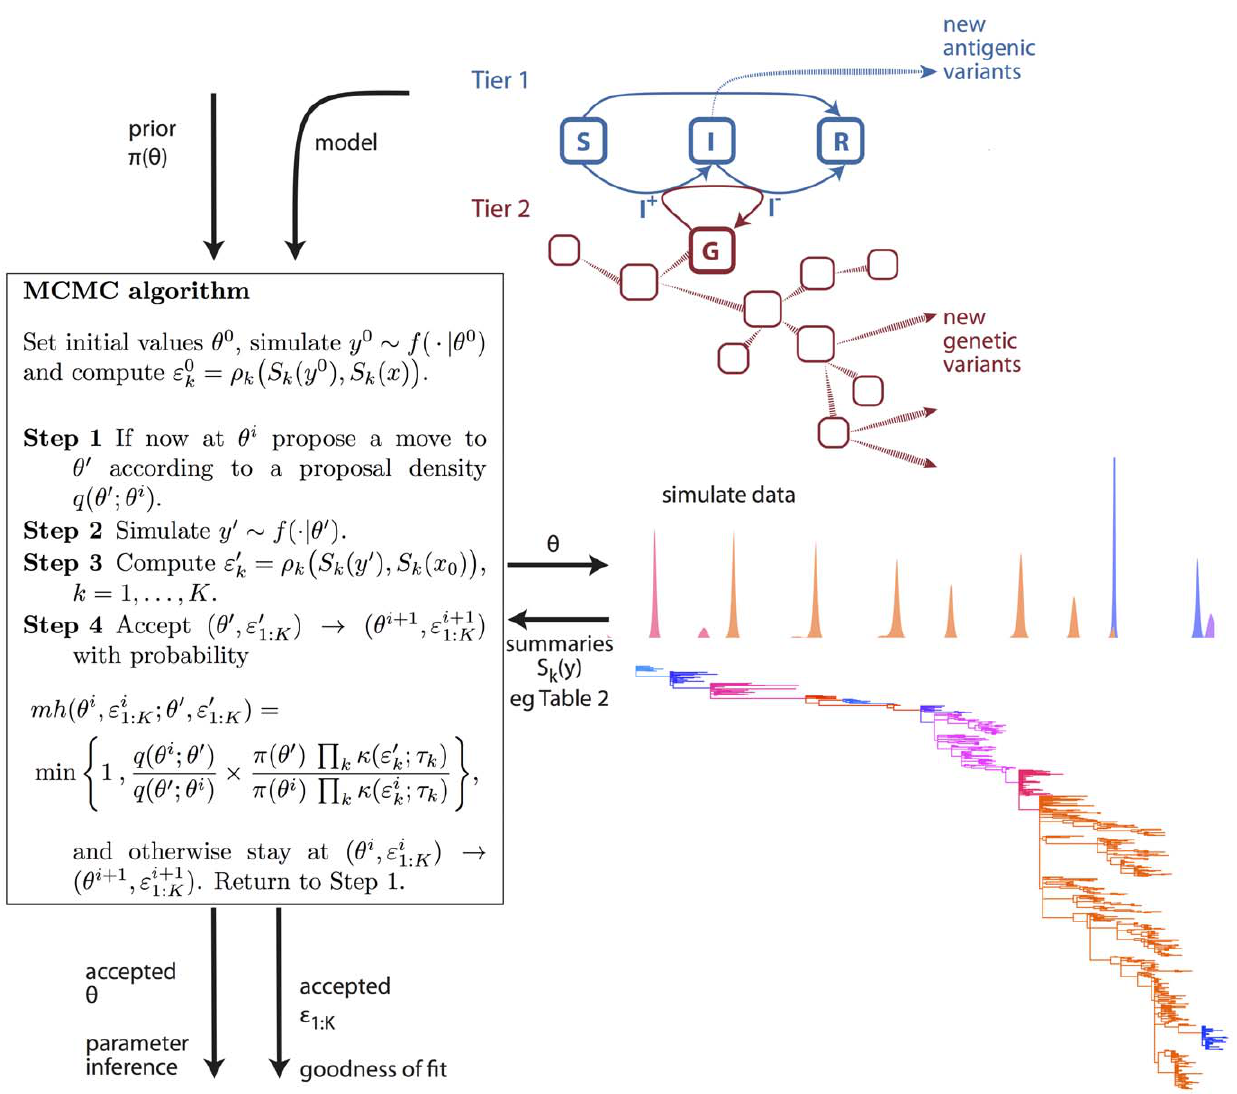
Figure 2. Overview of simulation-based phylodynamic inference and model assessment. Phylodynamic hypotheses are formulated into evolving, dynamical systems models. We used a two-tier model formulation whose genetic component is tied to its ecological component through the flows through the prevalence class. Existing knowledge on model parameters is incorporated through the prior p ( h ) , and Monte Carlo algorithms such as MCMC are used to fit the model to different types of data, e.g. incidence time series and reconstructed phylogenies (see Figure 1) with an ABC approach. ABC is based on likelihood approximations such as (2), which requires a specification of phylodynamic summaries (e.g. Table 1). The summary errors are used to diagnose if the fitted phylodynamic model is consistent with available data in terms of the specified